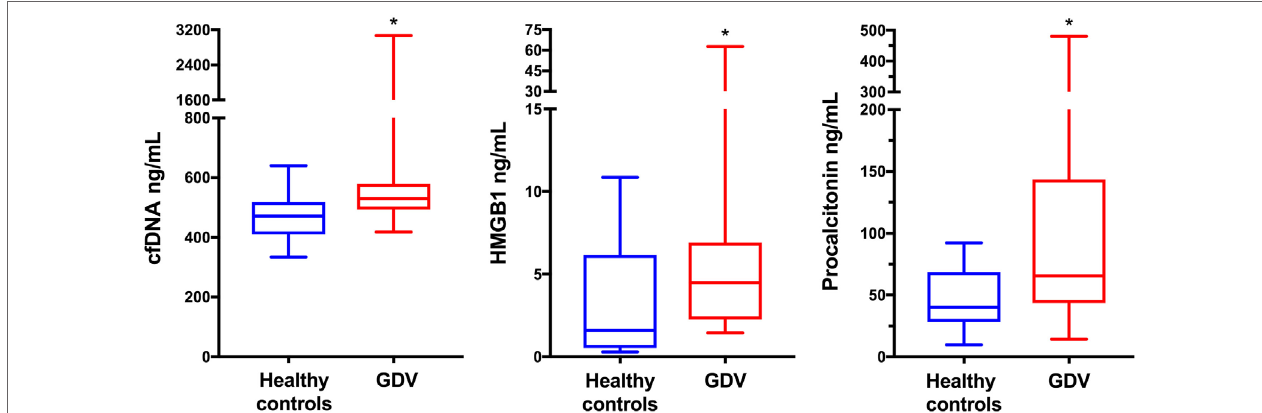
FigUre 1 | Box and whisker plot comparisons of plasma concentrations of cell-free DNA (cfDNA), high-mobility group box-1 (HMGB1), and procalcitonin (PCT) from 24 healthy control dogs and 29 dogs with gastric dilatation–volvulus (GDV) syndrome. The central line represents the median, the boxes represent the interquartile range and the whiskers represent the minimum and maximum values. * indicates statistical significance at P < 0.05. Dogs with GDV had significantly greater plasma concentrations of cfDNA, HMGB1 ( n = 28) and PCT ( n = 28) compared to healthy controls by Mann–Whitney U -test ( P = 0.0009, P = 0.004, and P = 0.009,